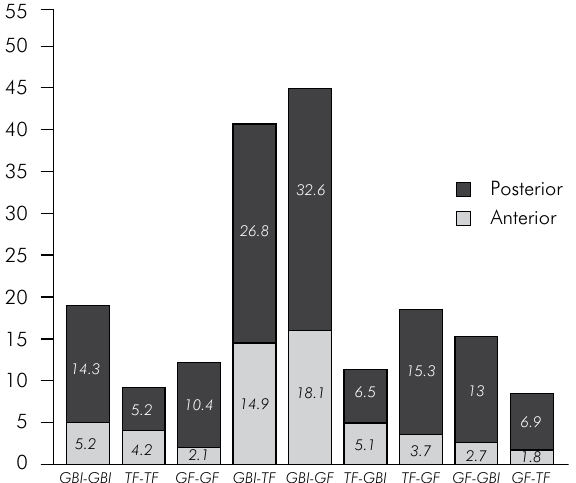
Figure 3. Percentage of bleeding sites in the first assessment and non-bleeding sites in the second assessment according to location in the anterior (incisors and canines) or posterior (premolars and molars) regions. There were statistically significant differences in the frequency of scores between posterior and anterior sites for all sequences (p < 0.05, McNemar’s test), except for TF-GBI (p =